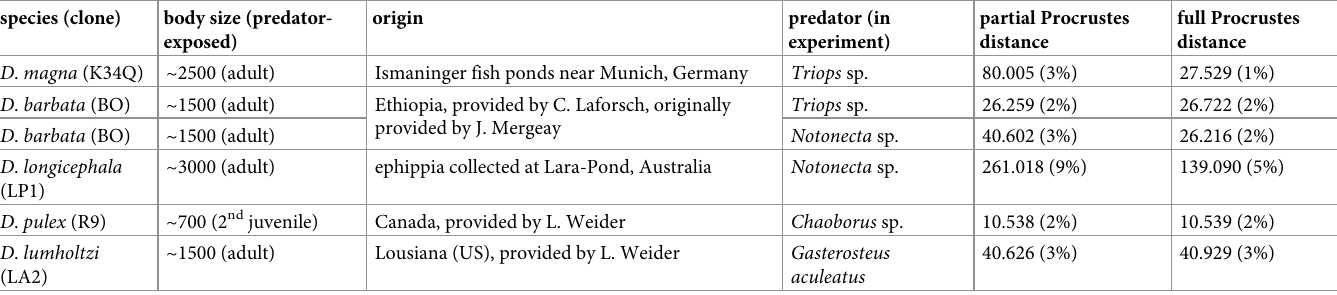
Table 1. Investigated Daphnia